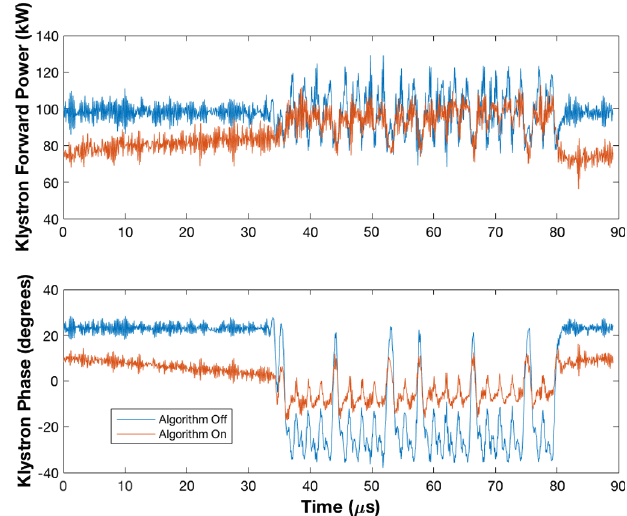
FIG. 4. Klystron power with 654 bunches, 50 ns spacing, 450